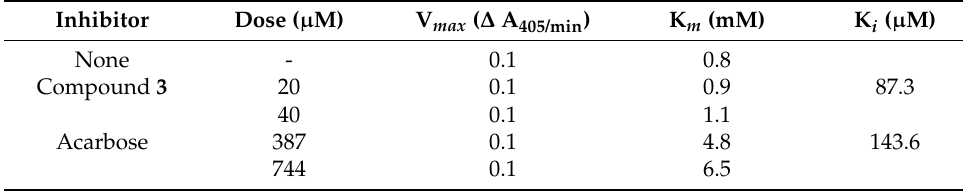
Table 4. Kinetic parameters of α -glucosidase inhibition in the presence of compound 3